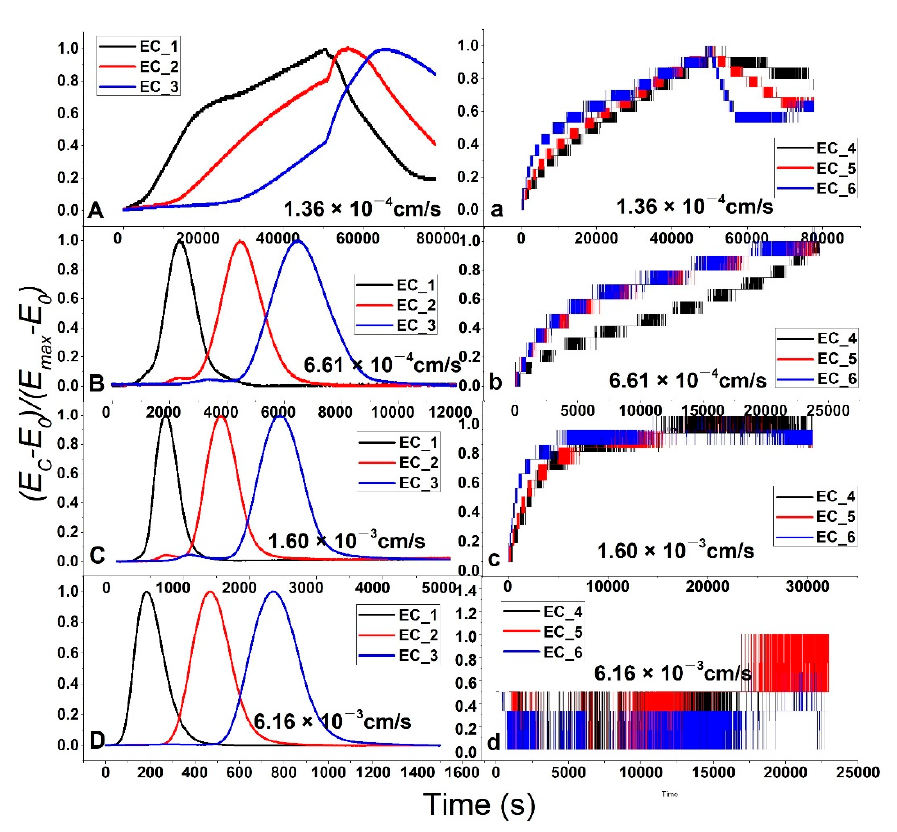
Figure 17. Dispersion mechanisms in coral sands having di ff erent pore flow velocities. (Figure 17A–D depicting the variation curves of measured conductivities from the sensors EC_1 to EC_3. Figure 17a–d depict the variation curves of measured conductivities from the sensors EC_4 to EC_6.)